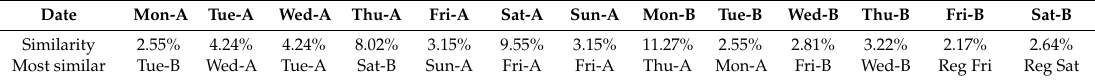
Table 9. Differences between special days type 3.